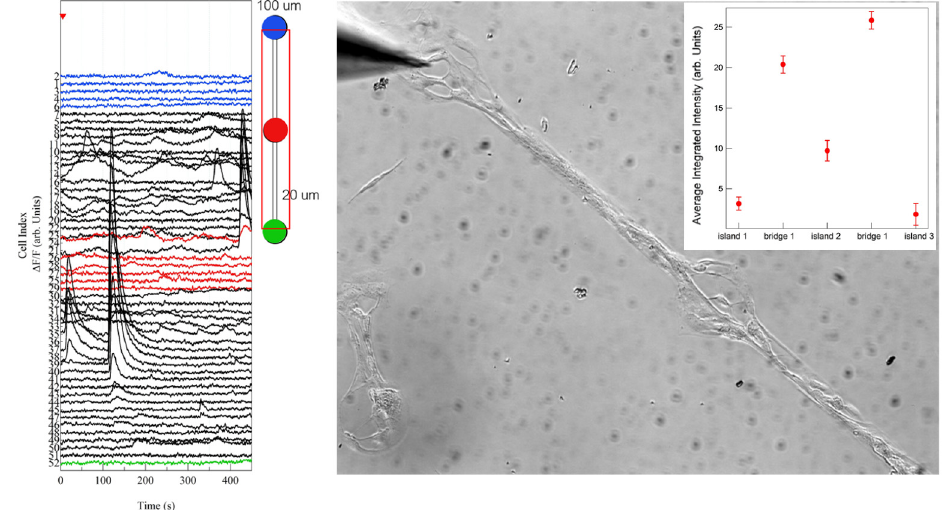
Figure 9. On the left are calcium intensity traces ( Δ F/F) of cells cultured on micropatterns as a function of time after the addition of glutamate solution (after 5 s) close to the dot schematically represented by blue colour. Different colours indicate the different location of the cells corresponding to the traces ( blue, red and green traces correspond to cells on dots; black traces correspond to cells on bridges). In the inset, the averaged integrated intensity of calcium signals referring to the different zones is reported.